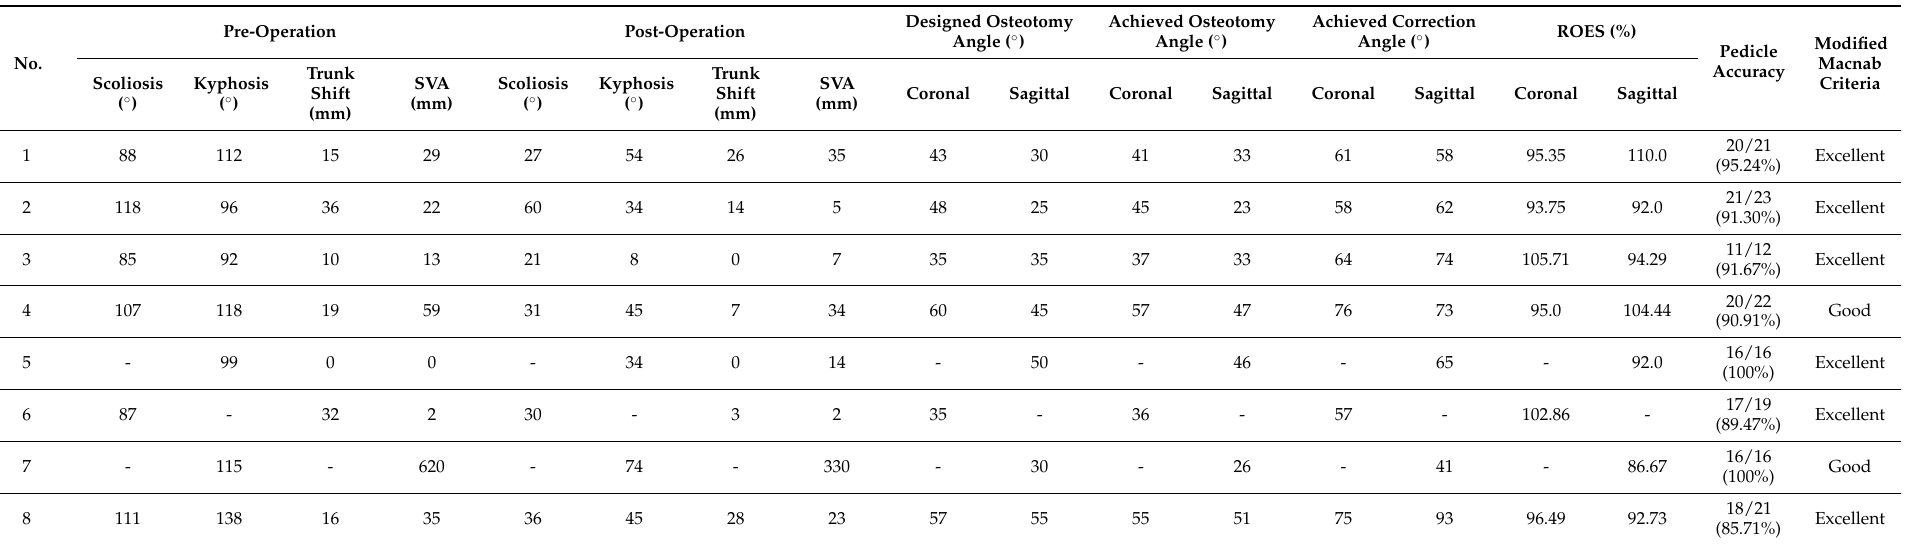
Table 2. Radiological parameters of enrolled